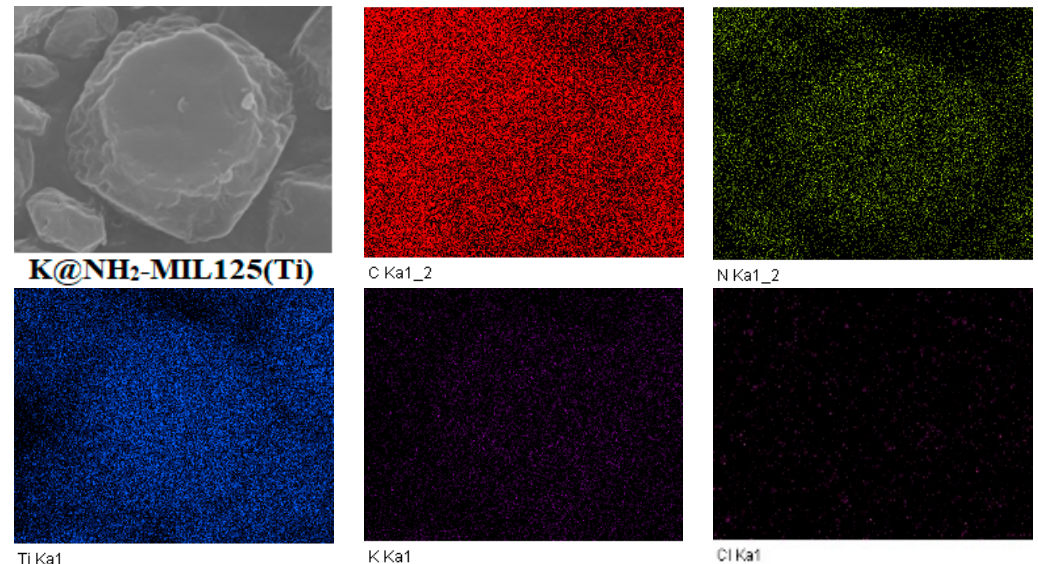
Figure 6. SEM–energy-dispersive spectroscopy (EDS) mapping of 1K@NH 2 –MIL125(Ti) elements: C, N, Ti, K, and Cl.